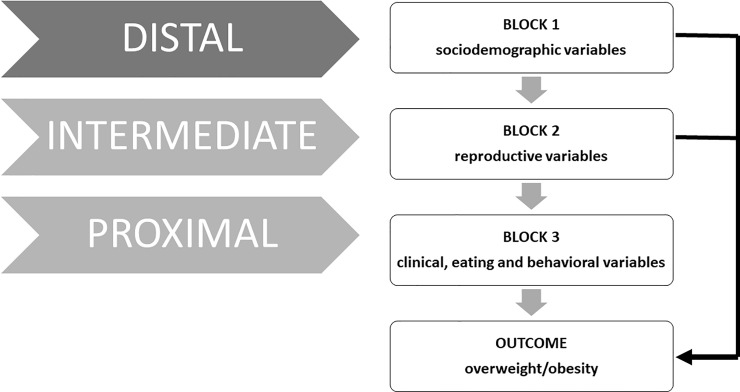
Model with the statistically significant variable selected in the bivariate analysis, and then adding other variables.